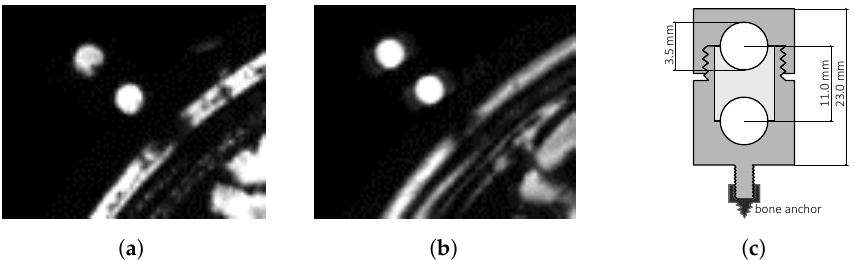
Figure 1. Marker depicted in ( a ) T1-weighted and ( b ) T2-weighted MRI and ( c ) as schematic drawing.